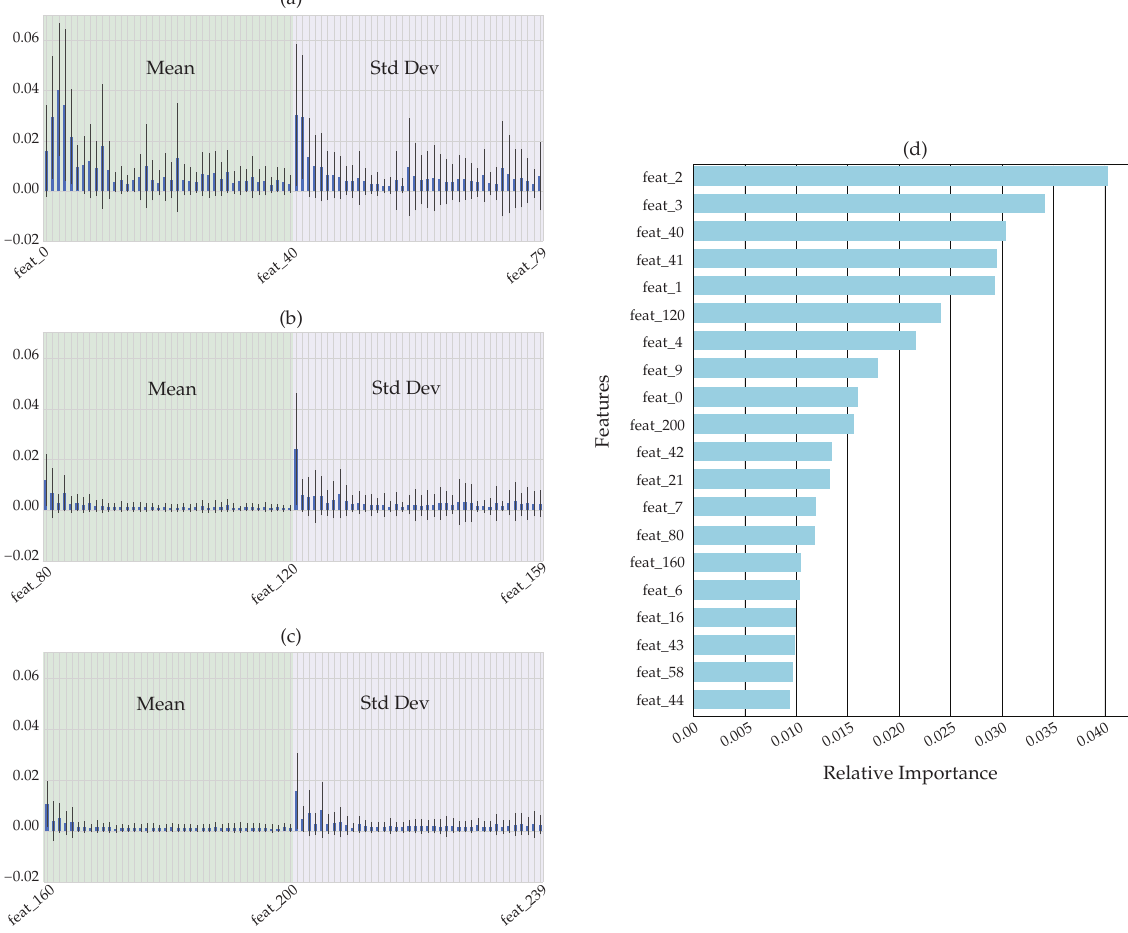
Figure 4. Random forest impurity-based feature importance showing the mean and standard devia- tion for ( a ) MFCC, ( b ) MFCC-Delta, ( c ) MFCC-Delta-Delta feature extraction and, ( d ) the 20 most important features in descending